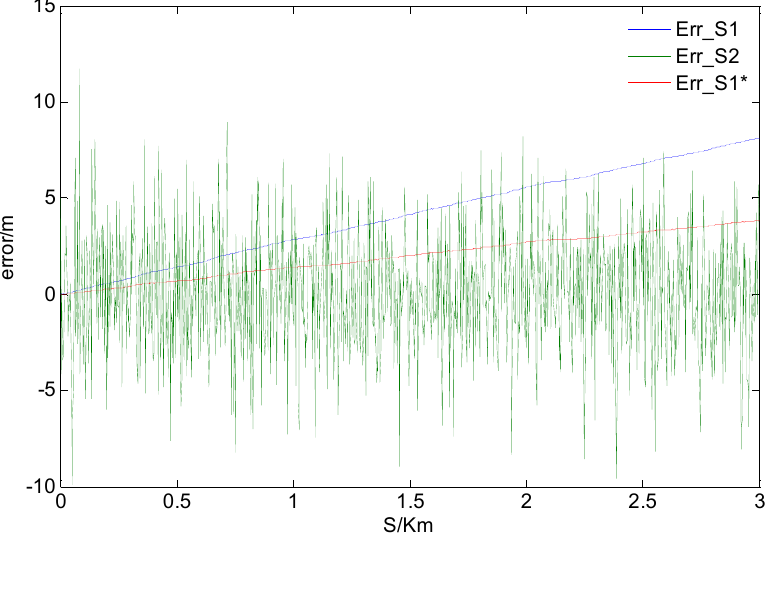
Figure 6. GPS calculated distance errors before and after LEC varies with increasing travel